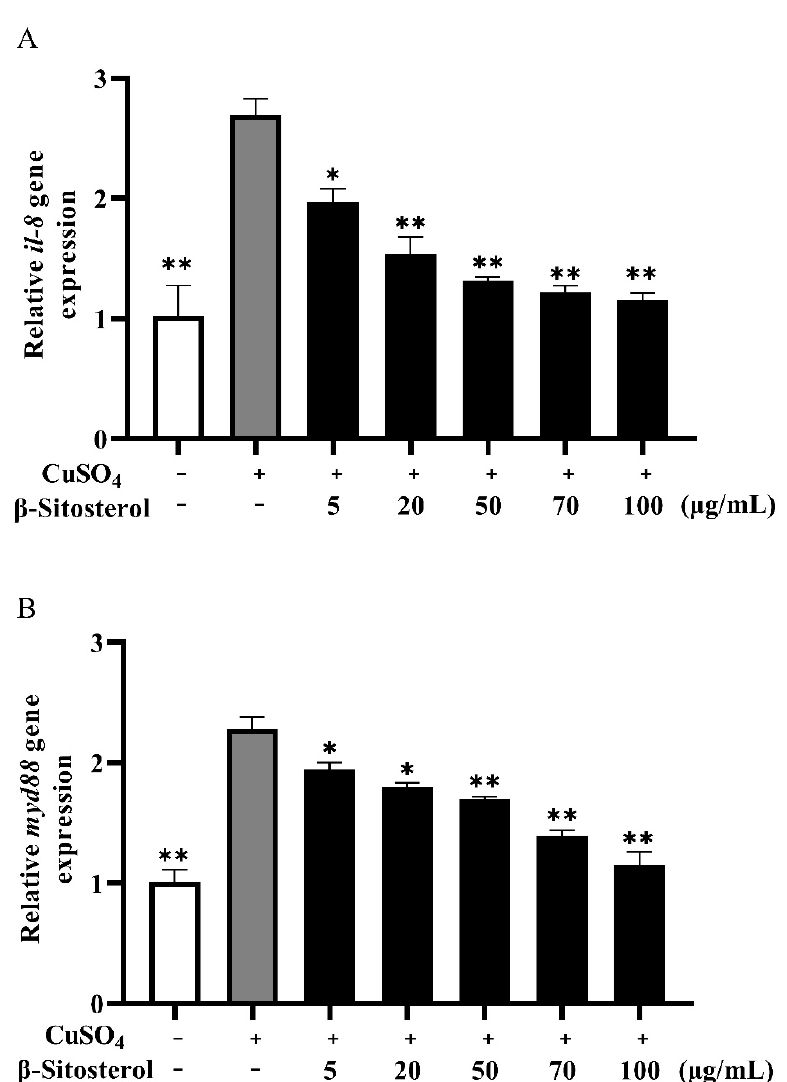
Figure 6. Relative expressions of immune response-related genes in zebrafish larvae after CuSO 4 stimulation and β -sitosterol treatment: ( A ) relative expression of the il-8 gene; ( B ) relative expression of the myd88 gene. The data are expressed as the mean ± standard error based on three biological replicates. * p < 0.05 and ** p < 0.01 compared with the group treated with CuSO 4 alone.